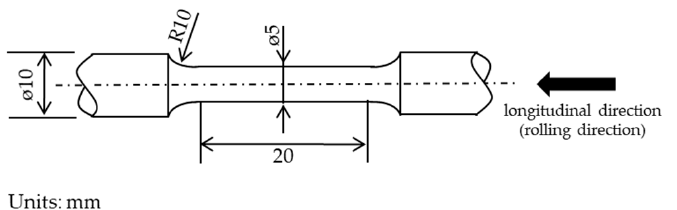
Figure 2. Shape and dimension of tensile and high cycle fatigue test specimen.